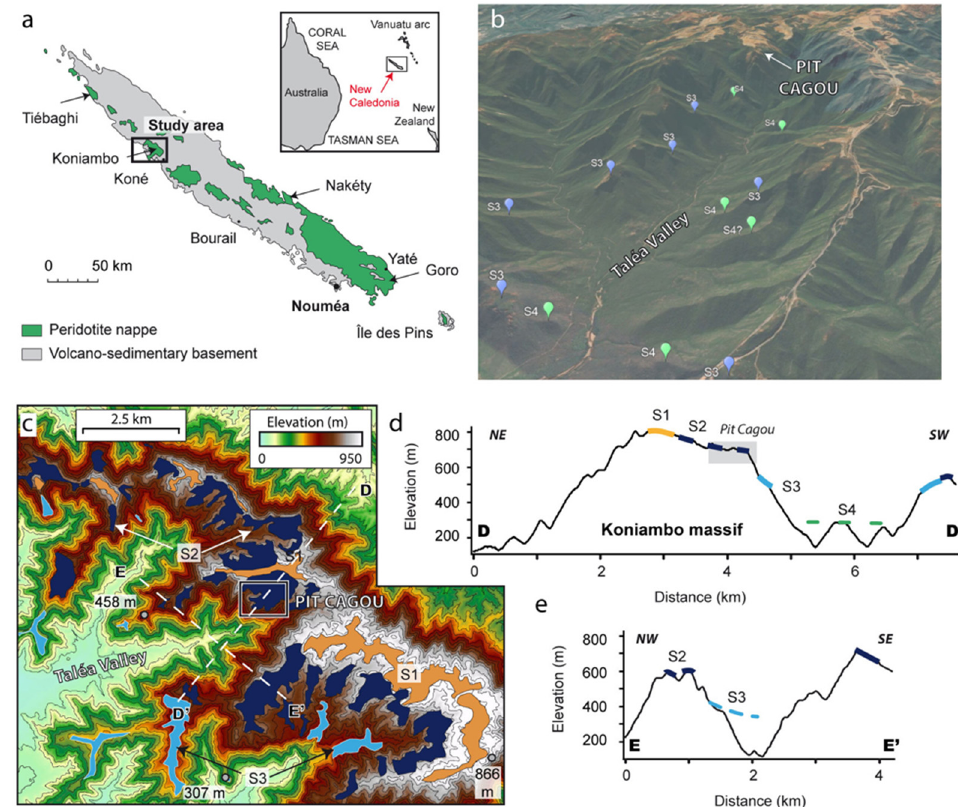
Figure 1. ( a ) Location of New Caledonia and Koniambo. ( b ) Aerial view with the indication of paleosurfaces (S1 to S4). ( c ) Location of the study site (open pit Cagou from KNS mining company) in the Koniambo massif. ( d , e ) Cross sections are in ( c ) (D-D’ and E-E’), with the indication of S1, S2, S3 paleosurface (in yellow, dark blue and light blue respectively) and the potential location of S4 (green dashed line).